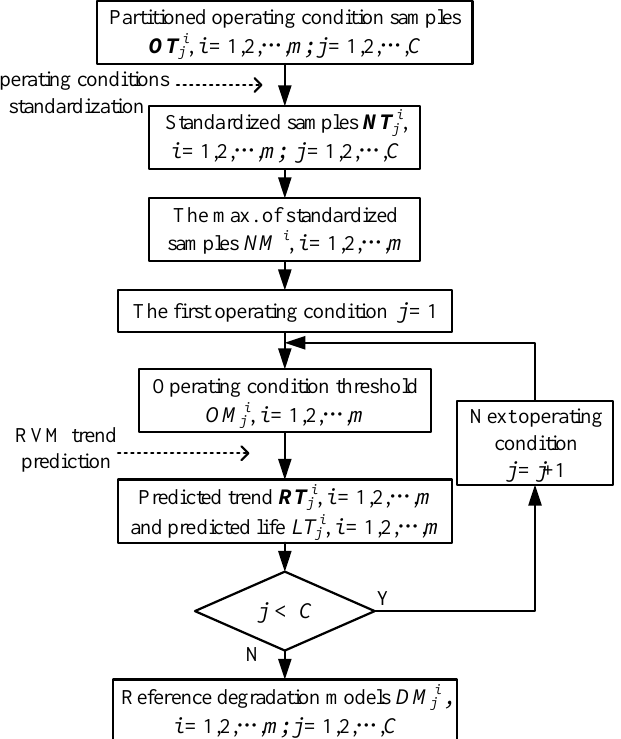
Figure 3. The process of the reference degradation models constructing.